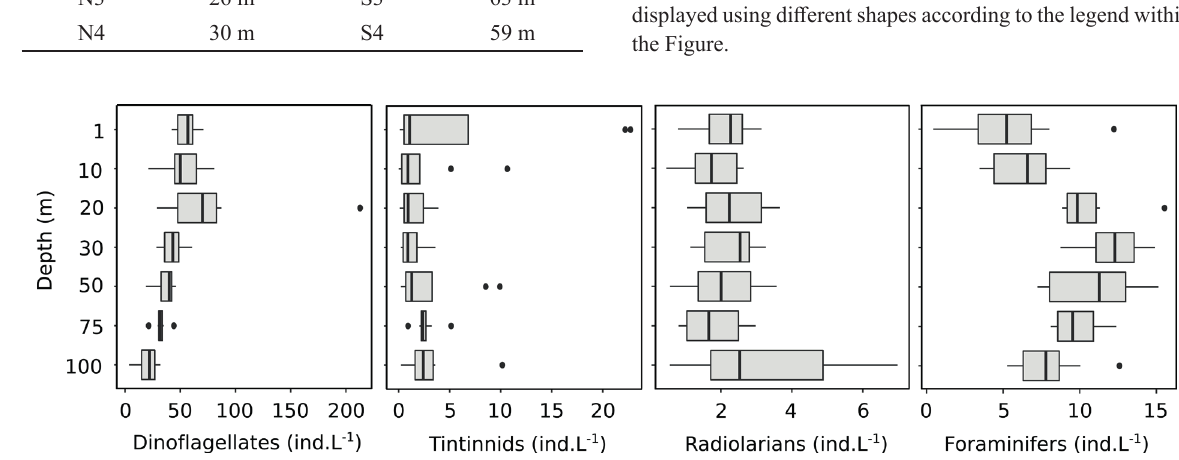
Figure 3 - Vertical distribution of the main microplanktonic protists assemblages in the upper 100 meters’ depth of the water column around the ASPSP.